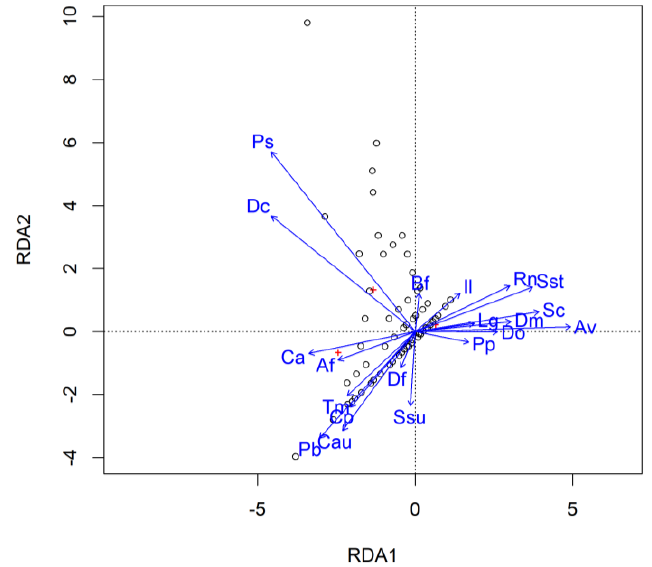
Figure 5. Redundancy analysis for the distribution of three liana species with respect to 20 tree species in a 20 ha subtropical forest dynamic plot in Chebaling (CBL), China. Tree species (explanatory variable), liana species, and sites are indicated by arrows, red crosses, and open circles, respectively. RDA axis 1 and 2 contributed to 68.3% and 19.1% of the variance explained by the model, respectively. Tree species: Ps: Phoebe sheareri ; Dc: Daphniphyllum calycinum ; Pb: Phoebe bournei ; Ca: Choerospondias axillaris ; Sc: Schoepfia chinensis ; Tm: Tarenna mollissima ; Lg: Lithocarpus glaber ; Rn: Rapanea neriifolia ; Do: Daphniphyllum oldhamii ; Sst: Symplocos stellaris ; Cp: Cinnamomum parthenoxylon ; Av: Antidesma venosum ; Pp: Photinia prunifolia ; Il: Ilex lohfauensis ; Ssu: Styrax suberifolius ; Dm: Diospyros morrisiana ; Bf: Beilschmiedia fordii ; Cau: Cinnamomum austrosinense ; Df: Diplospora fruticosa ; Af: Alni- phyllum fortunei.